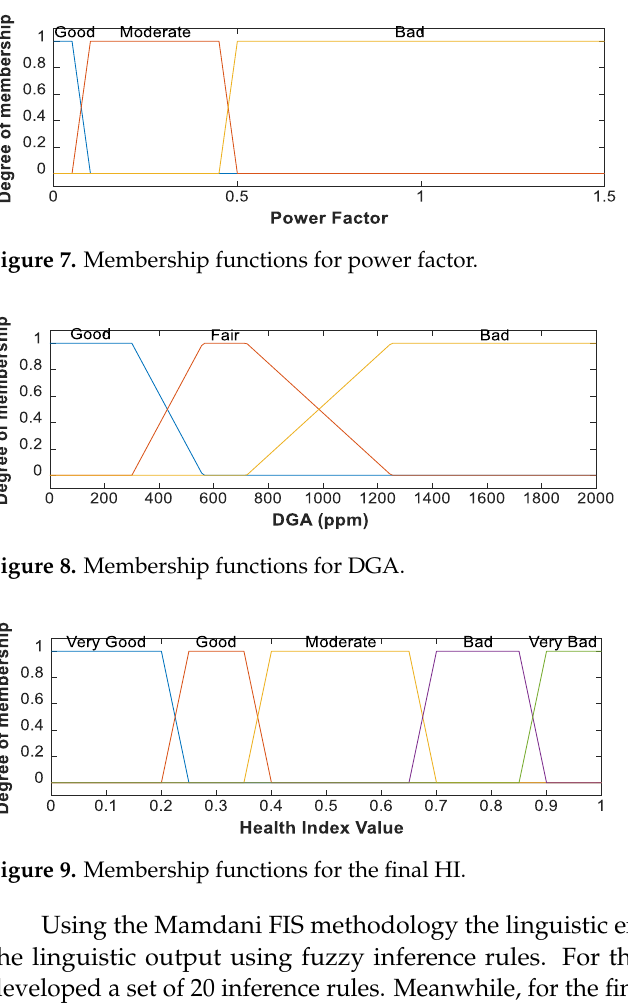
Figure 6. Membership functions for acidity.